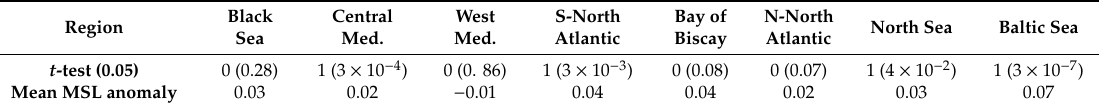
Table 3. Results of the t -test ( p -value in bracket) to check the hypothesis that the MSL anomaly data comes from a population with a mean greater than zero at the 0.05% significance level. A t -test = 1 indicates that the hypothesis is